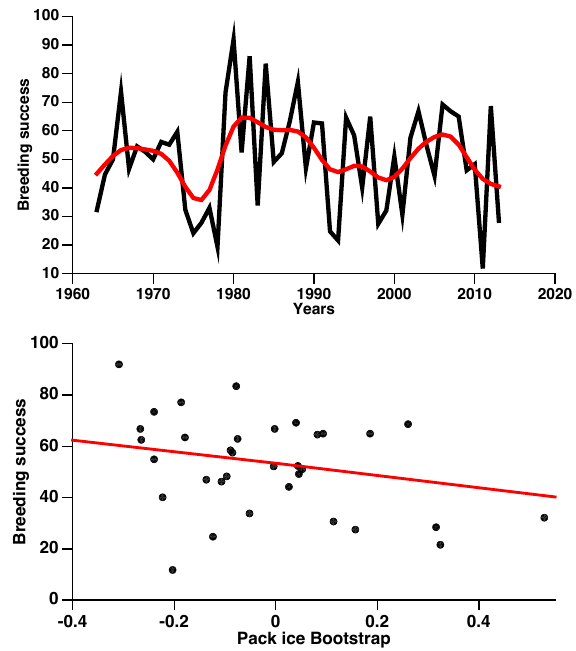
Figure 11. Breeding success of snow petrel (top) since the 1960s and the effect of the Bootstrap pack ice on the breeding success of snow petrels (bot- tom).